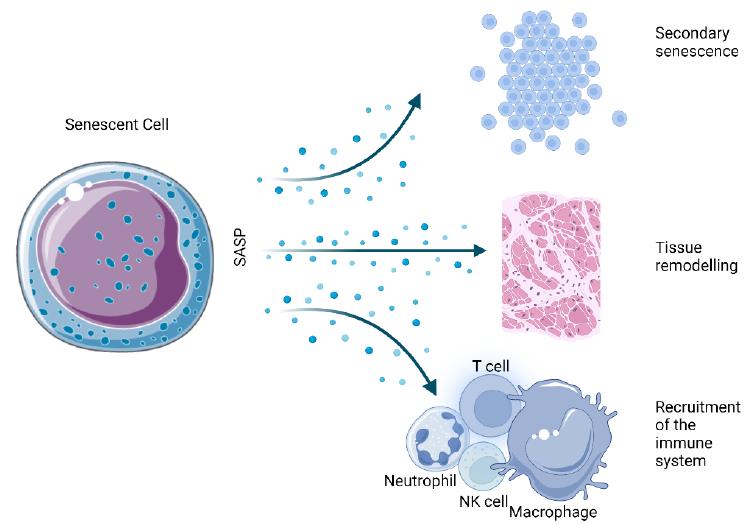
Figure 4. Physiological effects derived from the SASP of senescent cells.